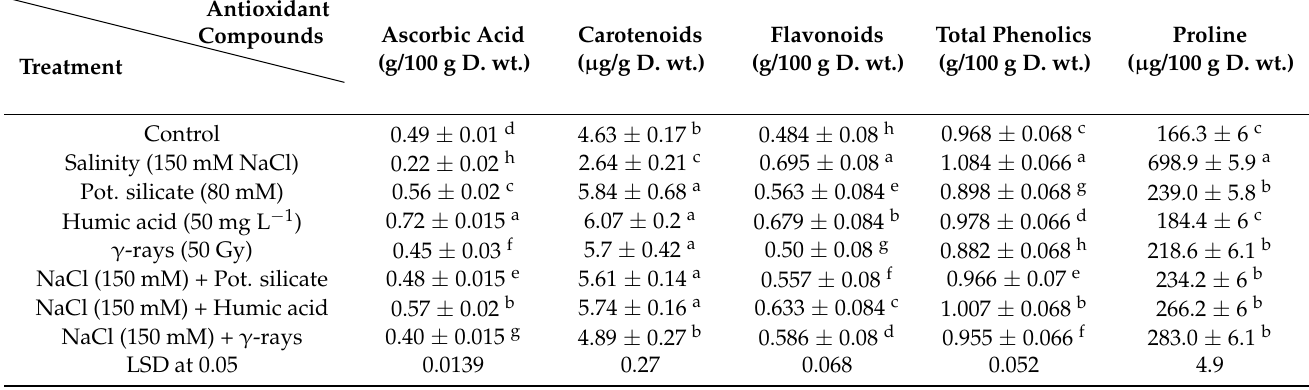
Table 7. Influence of biostimulants’ pretreatments on antioxidant compounds (ascorbic acid, carotenoids, flavonoids, total phenolics and proline) at flowering stage of coriander plants under salinity stress. Control and salinized stressed coriander samples were subjected to 80 mM pot. silicate, 50 mg L − 1 HA or soaked in water after exposure by 50 Gy γ -rays. Based on Duncan’s multiple range test, the different alphabetical letters express significant variation (defined as p < 0.05).